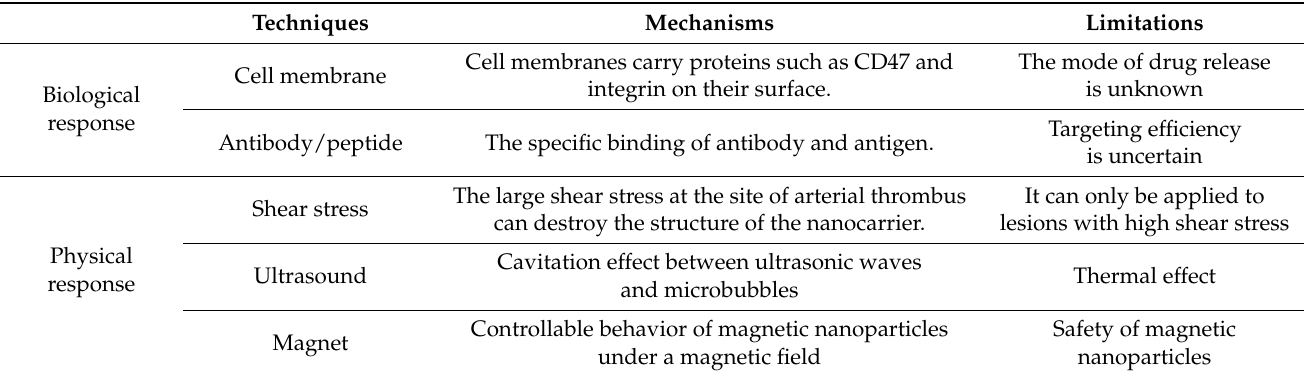
Table 3. Characteristics of various targeting